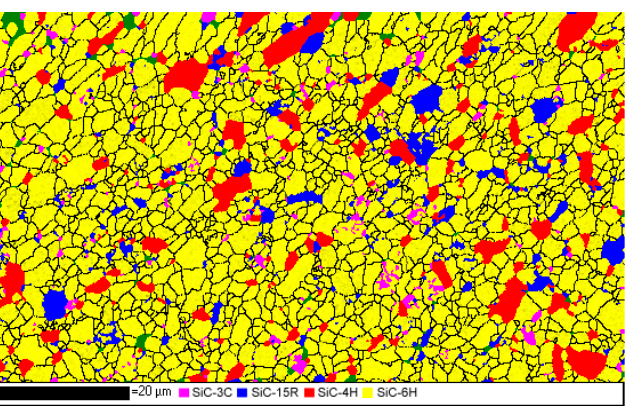
Figure 11. Example of the EBSD pattern of the 20/80 SiC sinter SiC-G.